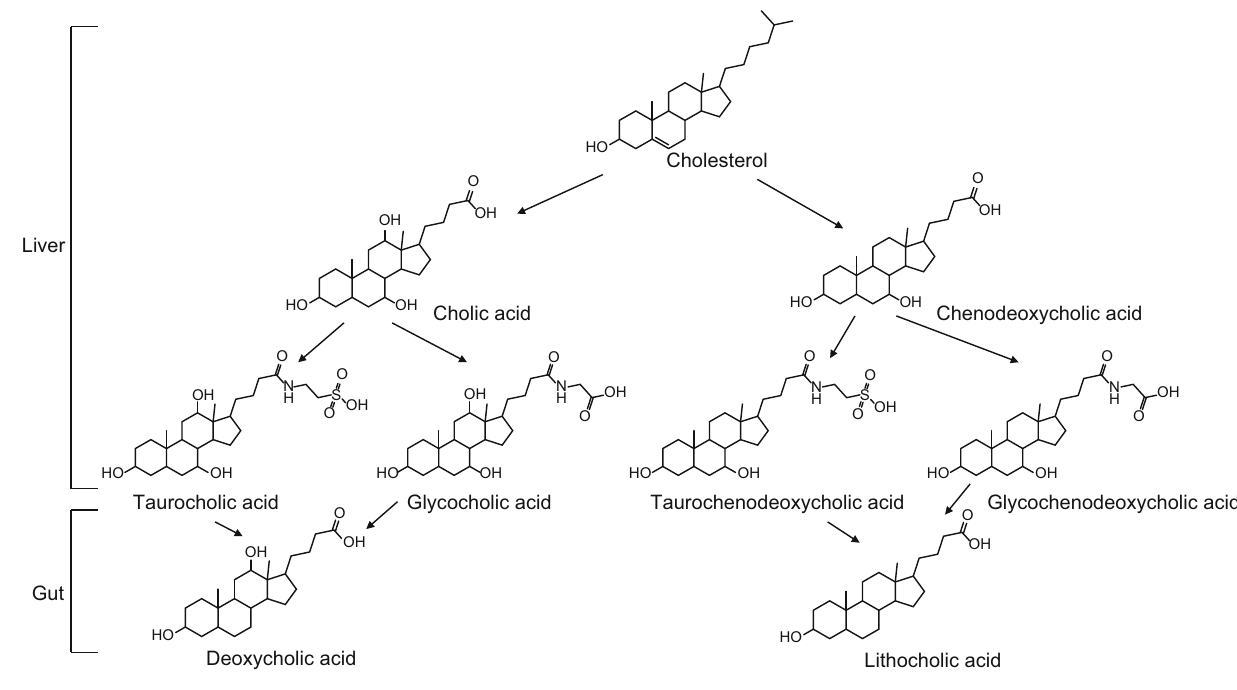
Figure 6. The main bile acids and their metabolic